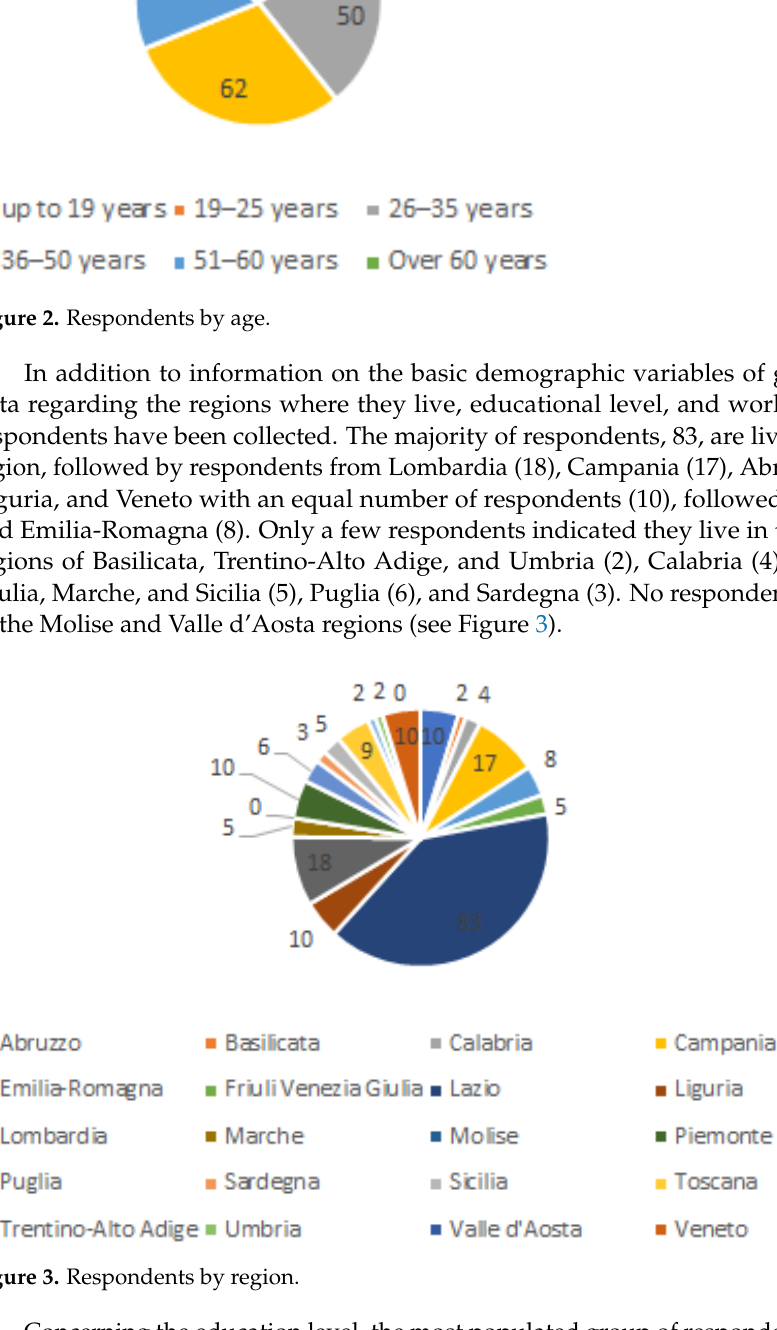
Figure 3. Respondents by region.